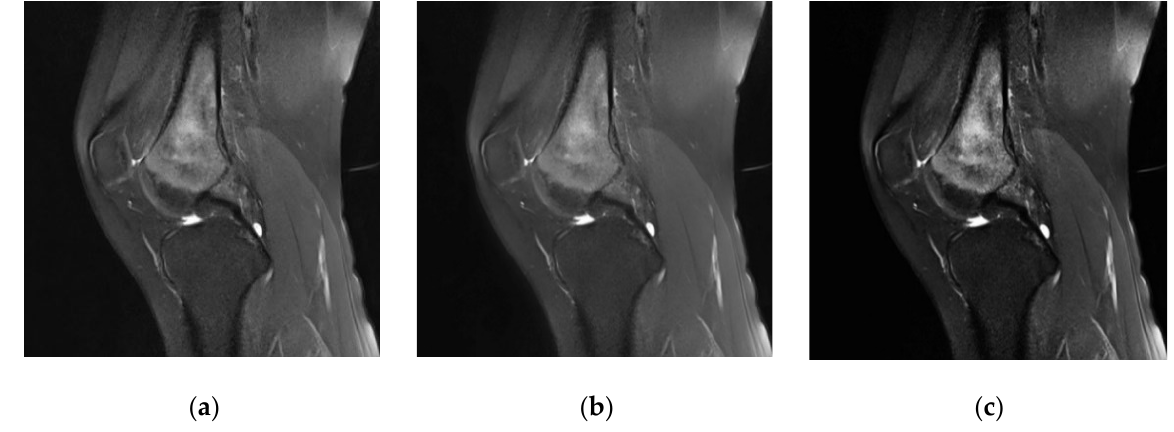
Figure 8. Denoising and tumor localization and enhancement renderings.